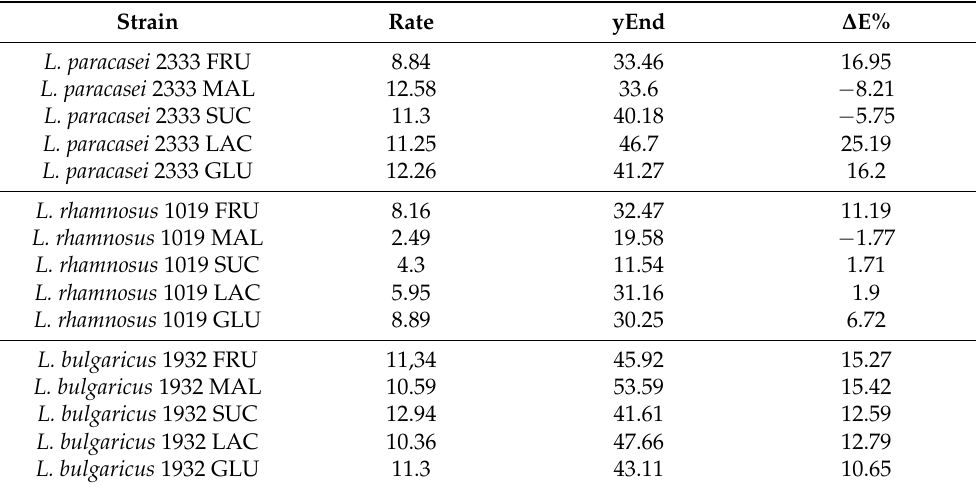
Table 1. Kinetic parameters (Rate), (yEnd) and ( ∆ E%) obtained by impedometric analysis of the tested strains. Strain Rate yEnd ∆ E% L. paracasei 2333